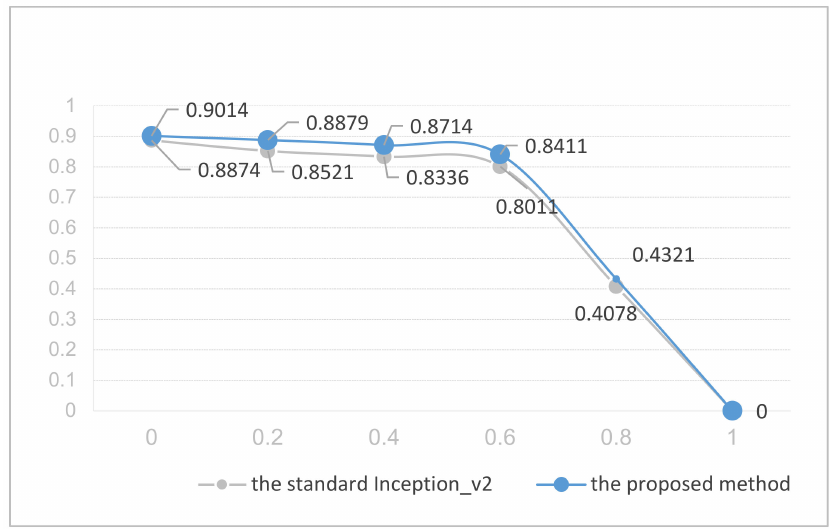
Figure 7. The trends in classification accuracy of standard Inception_v2 and the proposed method. Table 5. The truth labels in one category and the noisy labels are distributed to other categories. Percentage of